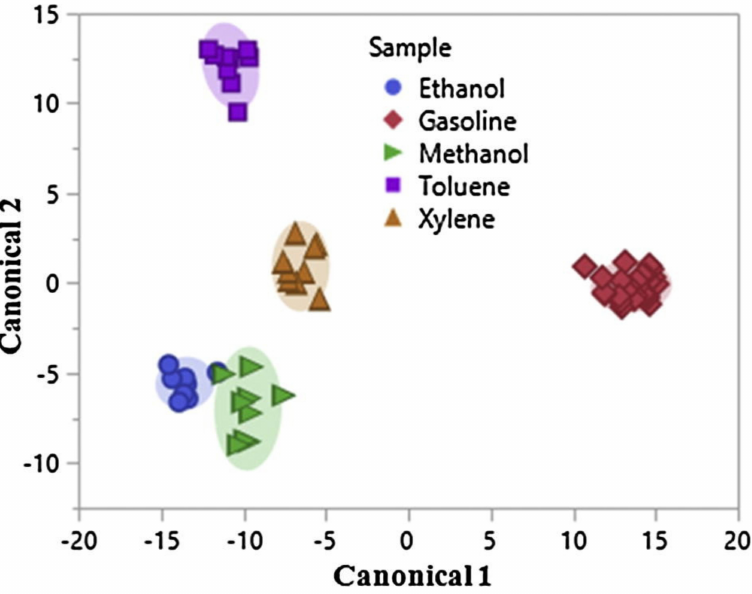
Figure 11. Linear discriminant analysis (LDA) canonical plot showing the discrimination of low-level gasoline adulteration using a V-MSA. Three concentrations of each sample were analyzed in triplicate. Adulterated samples are denoted as Ethanol, Methanol, Toluene, and Xylene. Each sample contains 1% v / v adulterant; 9 measurements per each adulterant were taken making 36 total measurement for four adulterated sample. The sample denoted as Gasoline contained all measurements (9 for each) for Exxon Regular, Exxon Plus, and Exxon Supreme making 27 total measurements. In this plot, there a total of 63 measurements. Figure is reproduced from